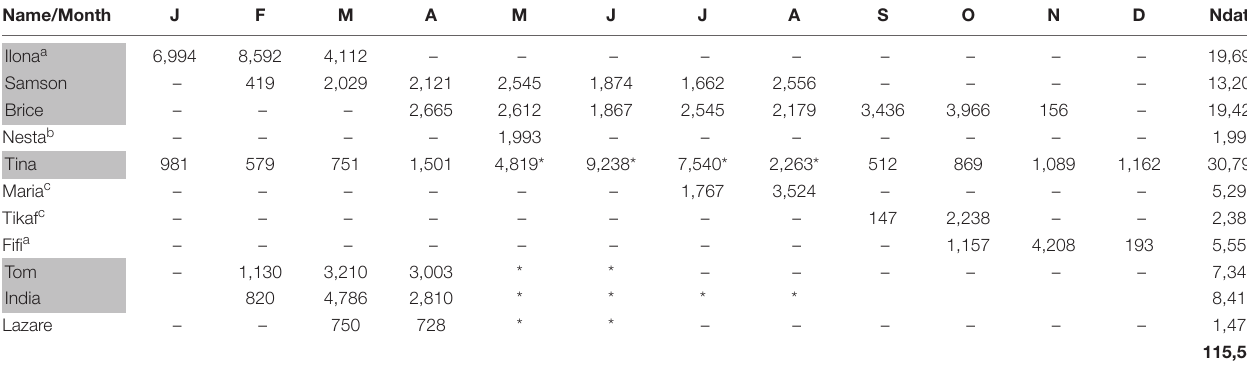
FIGURE 1 | Top panel: Photographs of (A) the loggerhead sea turtle “SAMSON,” which was released in April 2019 after being equipped with a WC SPLASH10 tag. (B) SAMSON release took place in the presence of a primary school class from Reunion Island as part of the outreach program “adopt a turtle.” Bottom panel: loggerhead and Olive Ridley turtles “TOM” (C) and “LAZARE” (D) , respectively, released in February and March 2020 after being equipped with LK Kiwisat tags. The underwater photography (D) is extracted from a documentary made by Euronews in February 2020 (https://www.euronews.com/2020/03/30/meet-the- researchers-using-sea-turtles-to-learn-more-about-cyclones). TABLE 2 | Number of temperature observations collected by the 11 STs of the STORM program as of 30 April 2020 indicated by month (JFMAMJJASOND) and by individual (Ndata) with total number shown in bold.